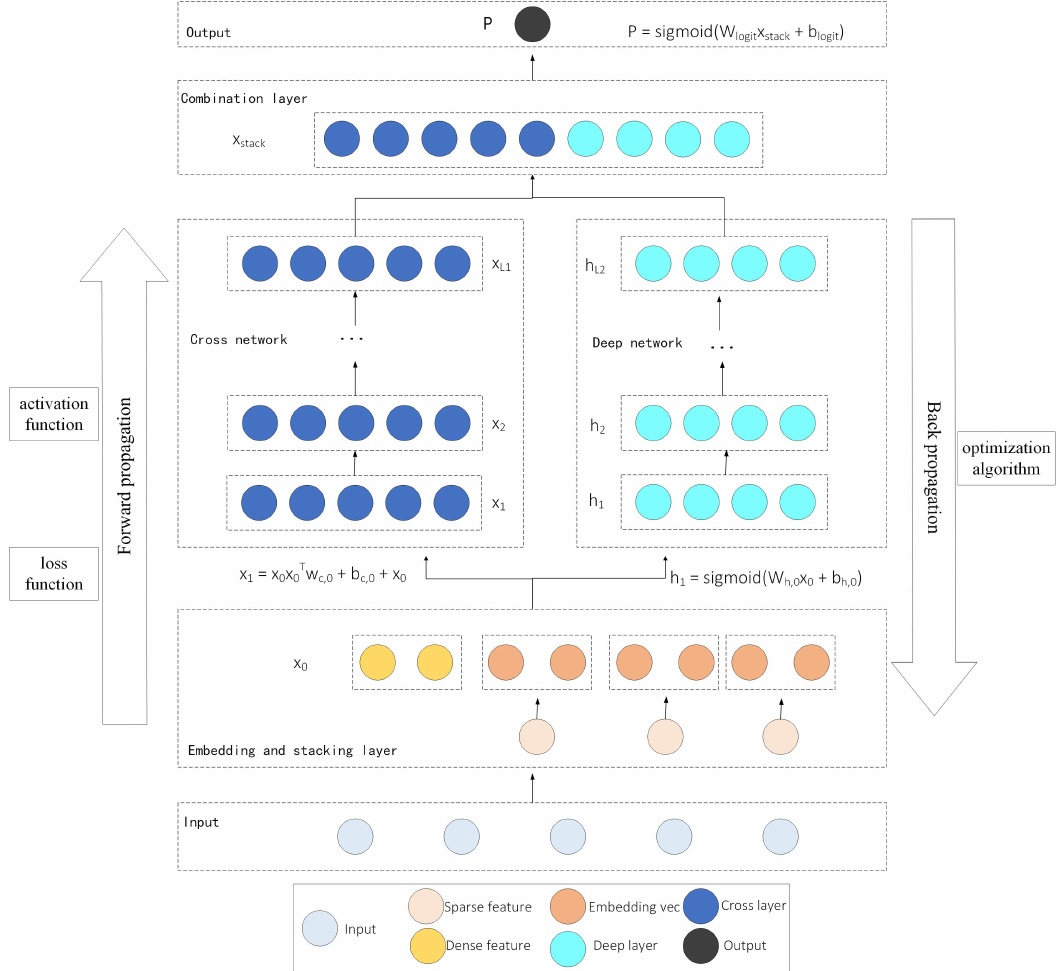
Figure 1. The FO-Follow The Regularized Leader (FTRL)-Deep&Cross Network (DCN)